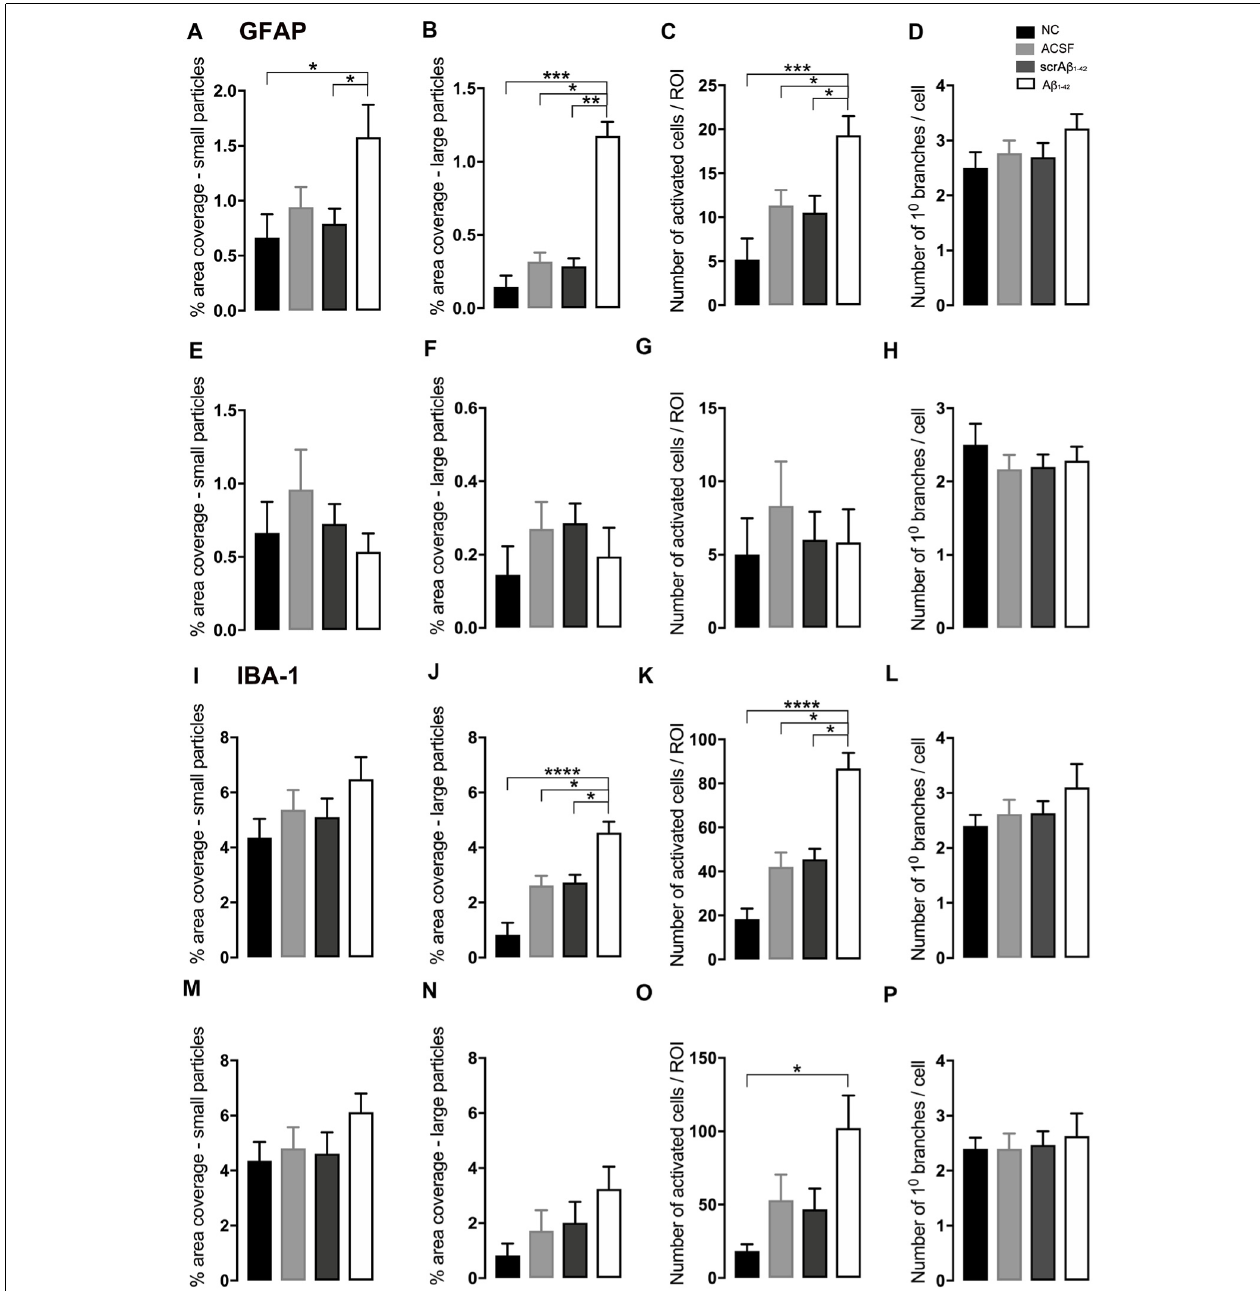
FIGURE 6 | Graphs showing quantification of astrocytic and microglial morphology at the injection site (A–D,I–L) and a location adjacent to the injection site (E–H,M–P) in the CA1 hippocampal region 30 days post-injection in NC, ACSF-, scrA β 1–42 - and A β 1–42 -injected mice. Data expressed as mean ± SEM (Kruskal–Wallis test; * p < 0.05, ** p < 0.01, *** p < 0.001, **** p < 0.0001, n =